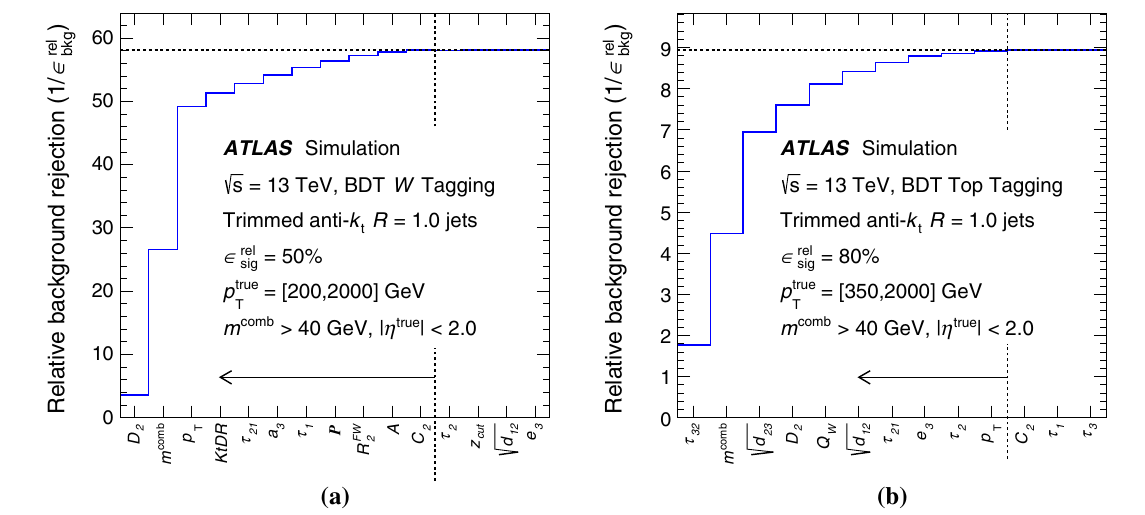
Fig. 3 The relative background rejection of the jet-shape-based BDT discriminant for different sets of variables, with more variables added successively at the 50% ( W -boson tagging) and 80% (top-quark tag- ging) relative signal efficiency working point for W -boson ( a ) and top-quark ( b ) tagging. Only jets which satisfy the training criteria are considered when calculating the relative signal efficiency and relative